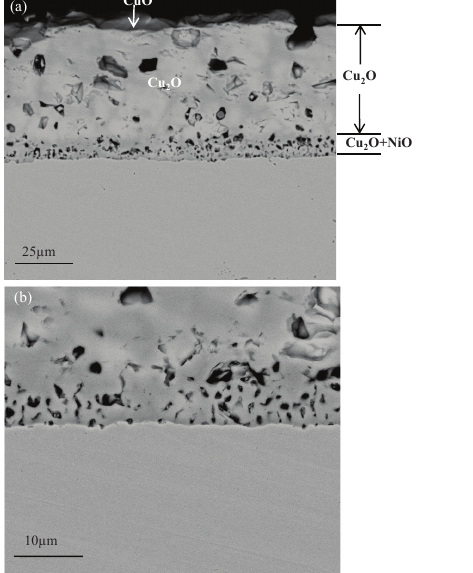
Figure 2. BEI micrographs of a cross section of Cu-0.2Ni oxidized at 800°C in 1 atm O 2 for 30 min. (a) General view; (b) Enlarged view of the scale/alloy interface.